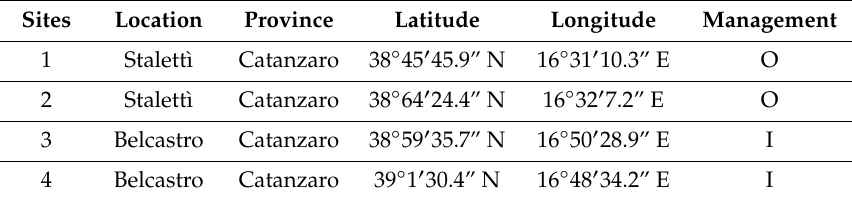
Table 1. Locations and di ff erent management systems of olive groves used in the comparison of damage caused by Liothrips oleae . Organic management (O), integrated management